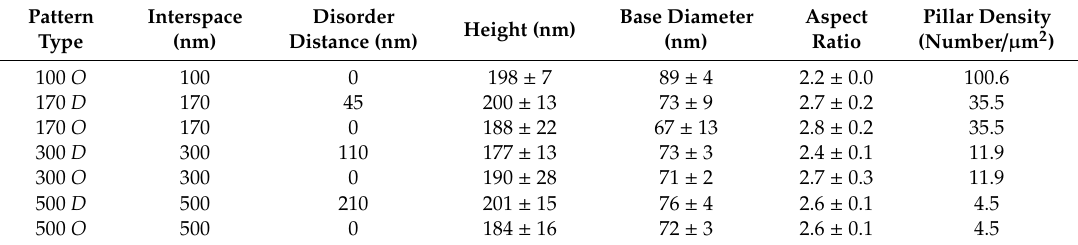
Table 1. The characteristics of the nanopatterns produced by